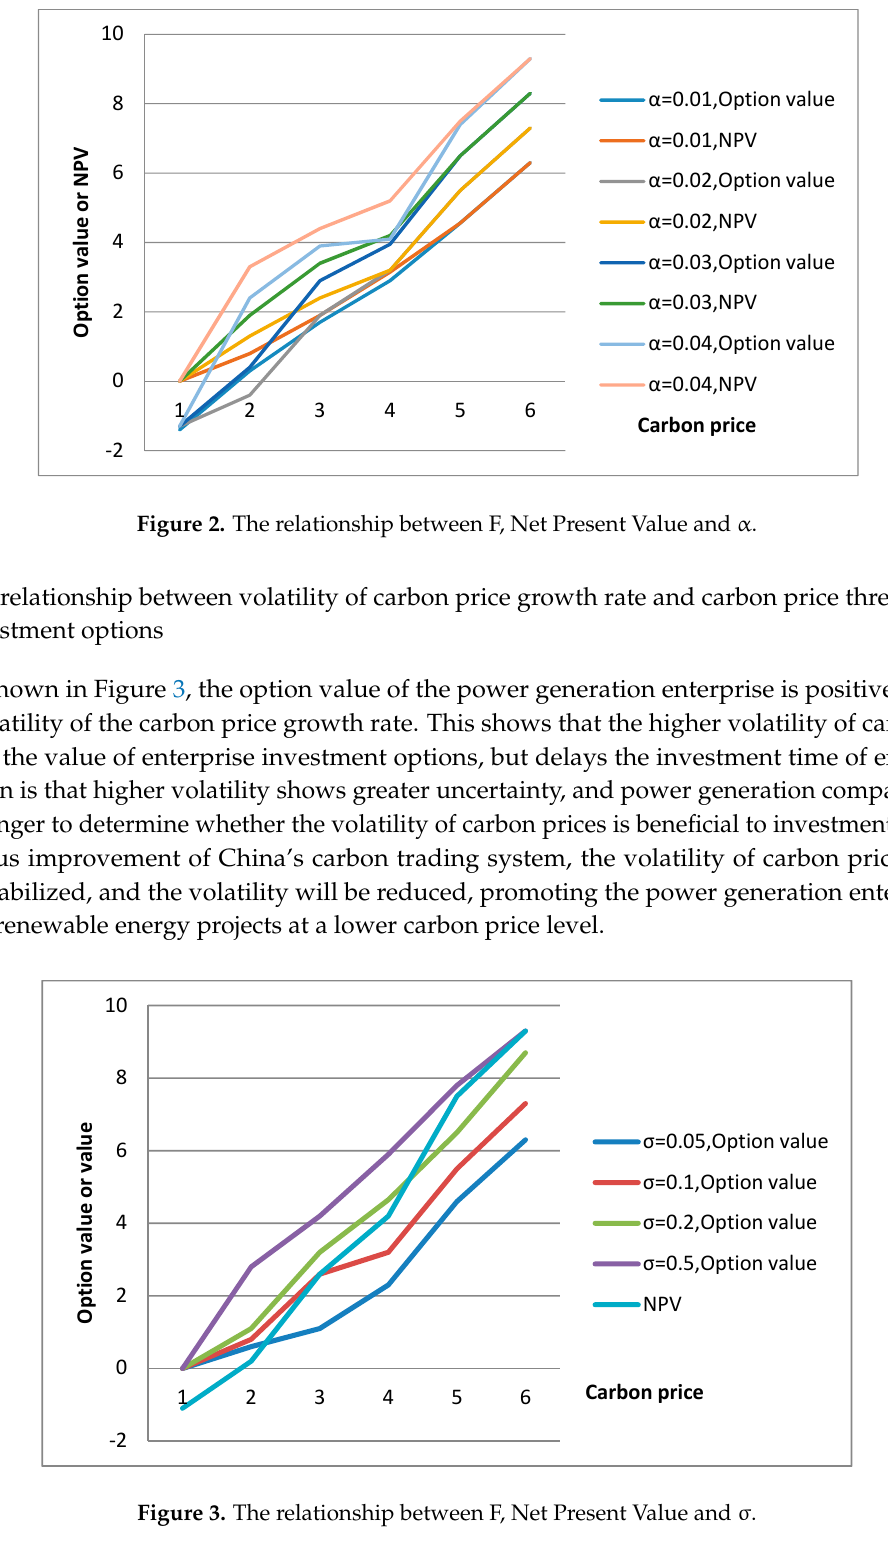
Figure 3. The relationship between F, Net Present Value and σ .